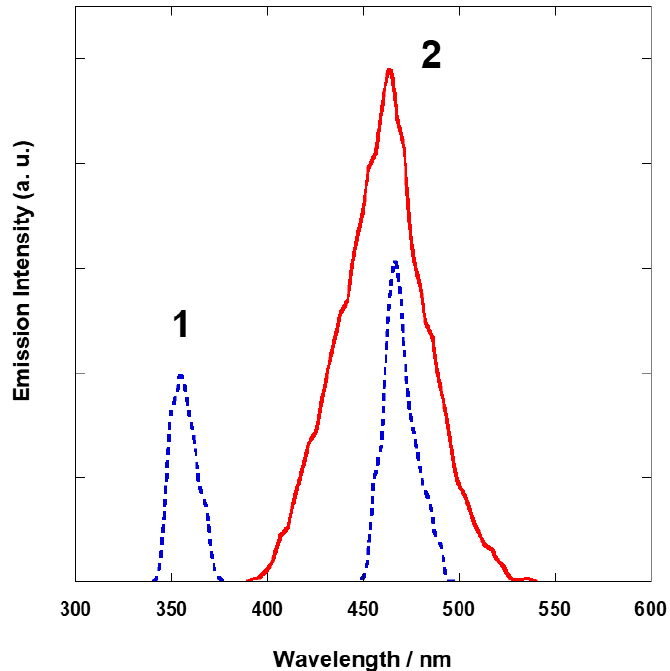
Figure 7. Photoluminescence spectra ( λ ex = 300 nm) of polymers 1 (dotted line, blue) and 2 (solid line, red).